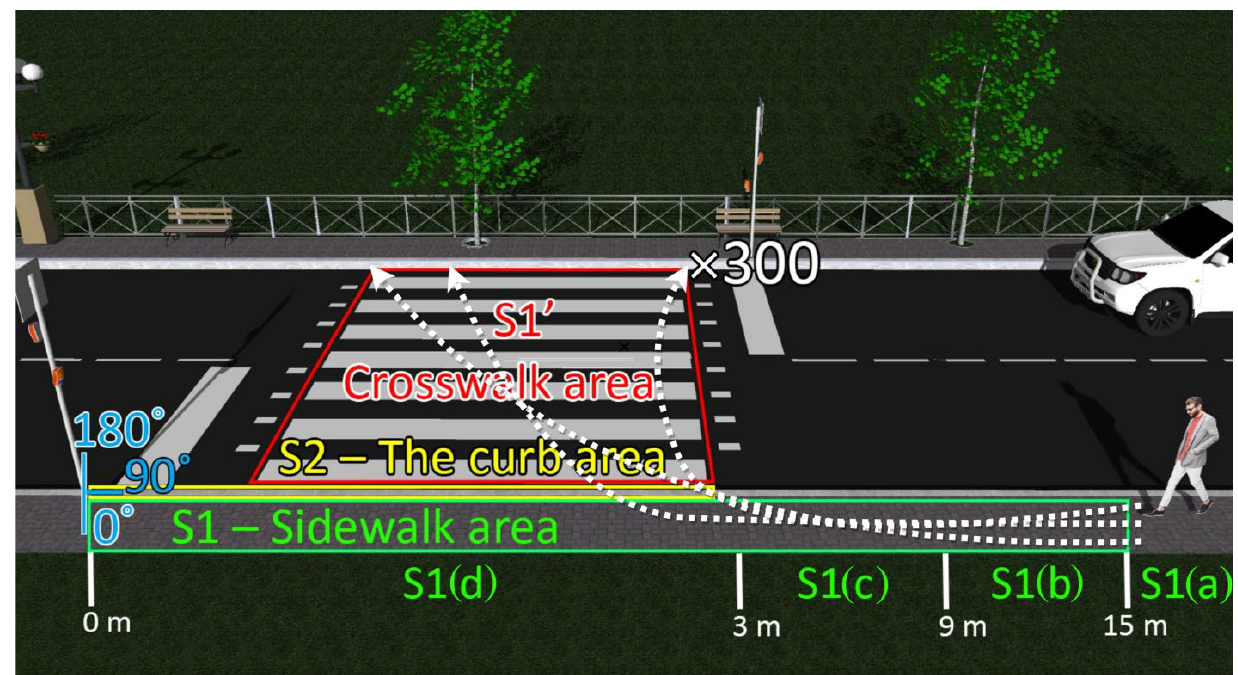
Figure 6. Workflow for the pedestrian presence and localization algorithm.